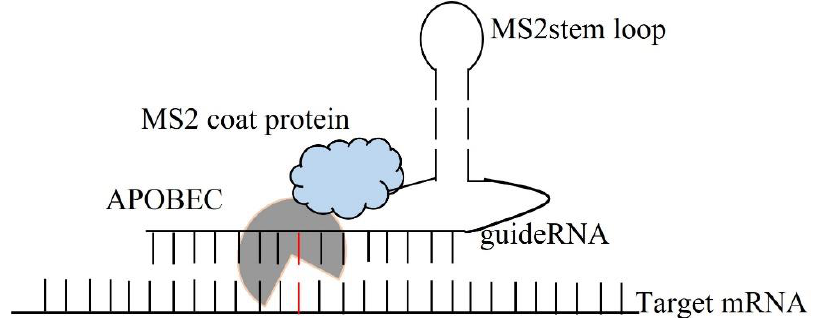
Figure 3. Enzymatic C to U RNA editing by APOBEC 1 deaminase.